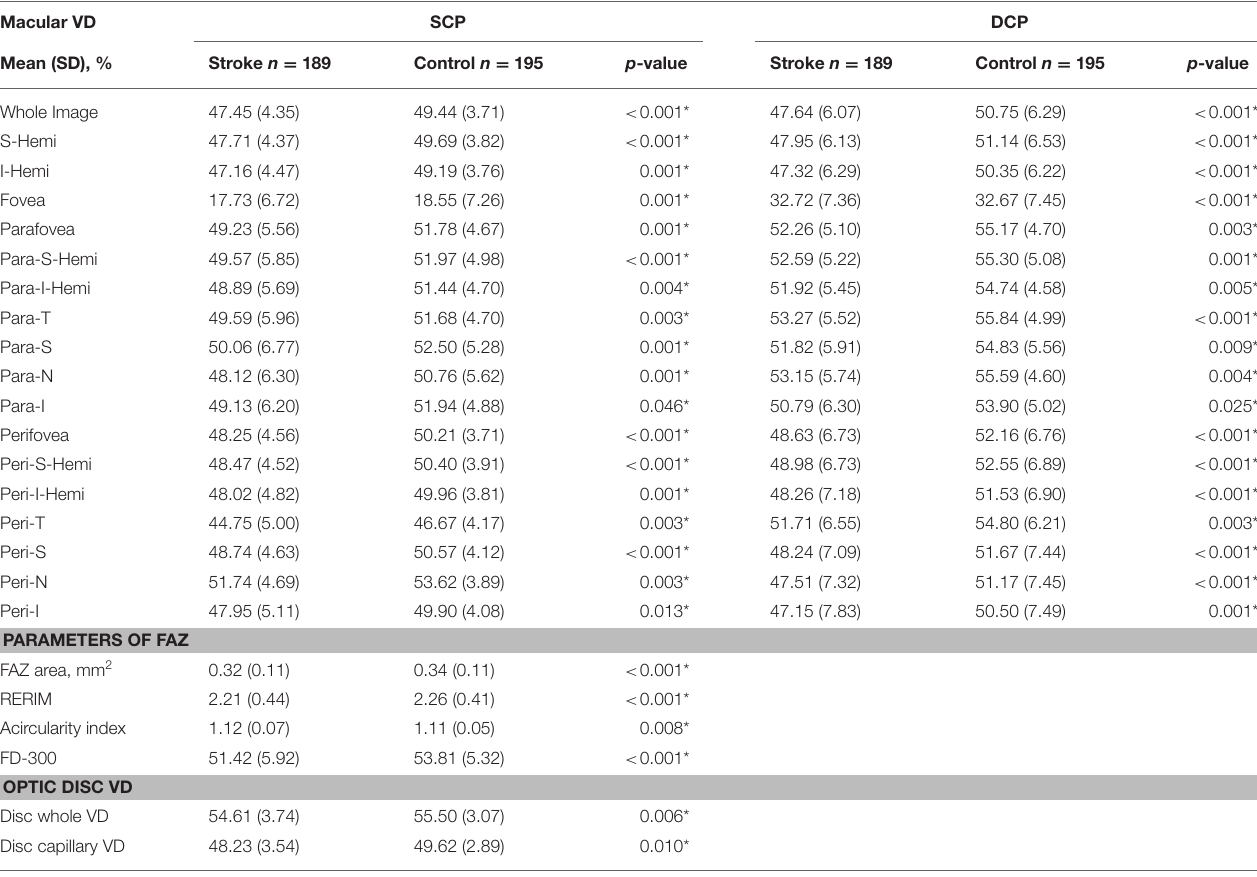
TABLE 2 | Comparison of OCTA parameters in the two groups ( n =